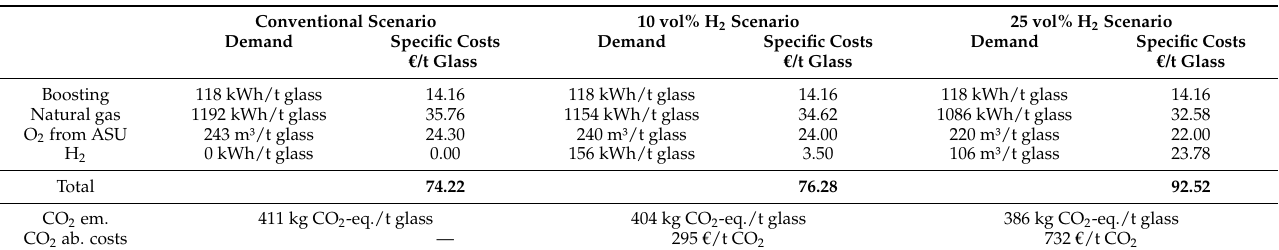
Table 5. Comparison of the various and total specific energy costs and CO 2 abatement costs of the conventional scenario (i.e., merely oxyfuel glass melting) with the scenarios including the integration of a PtH 2 into oxyfuel glass melting with 10 vol% H 2 and 25 vol% H 2 in the fuel mixture,